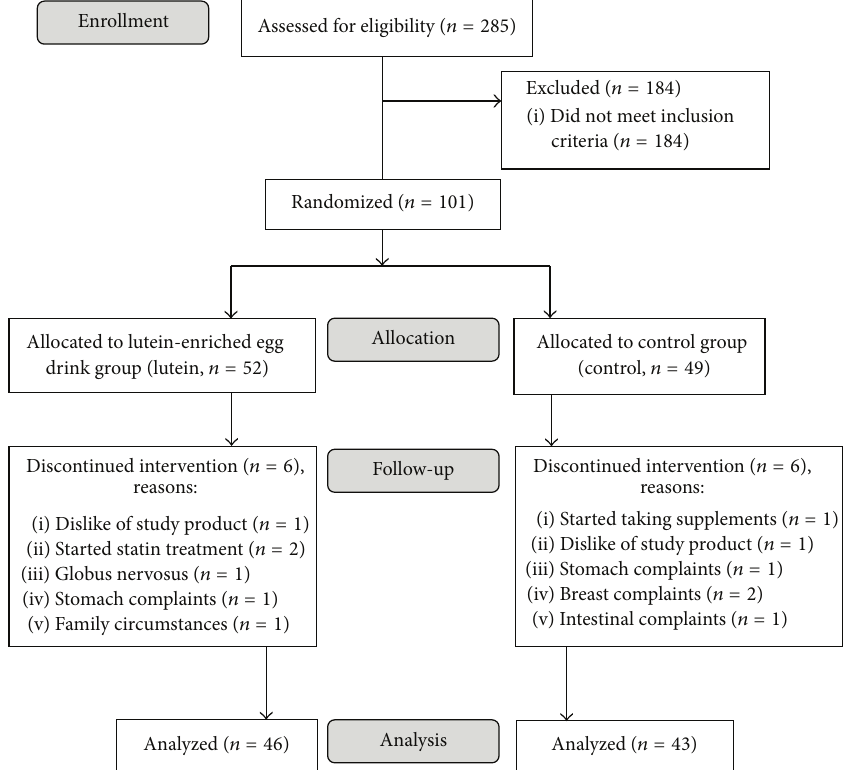
Figure 1: Subject flow chart.